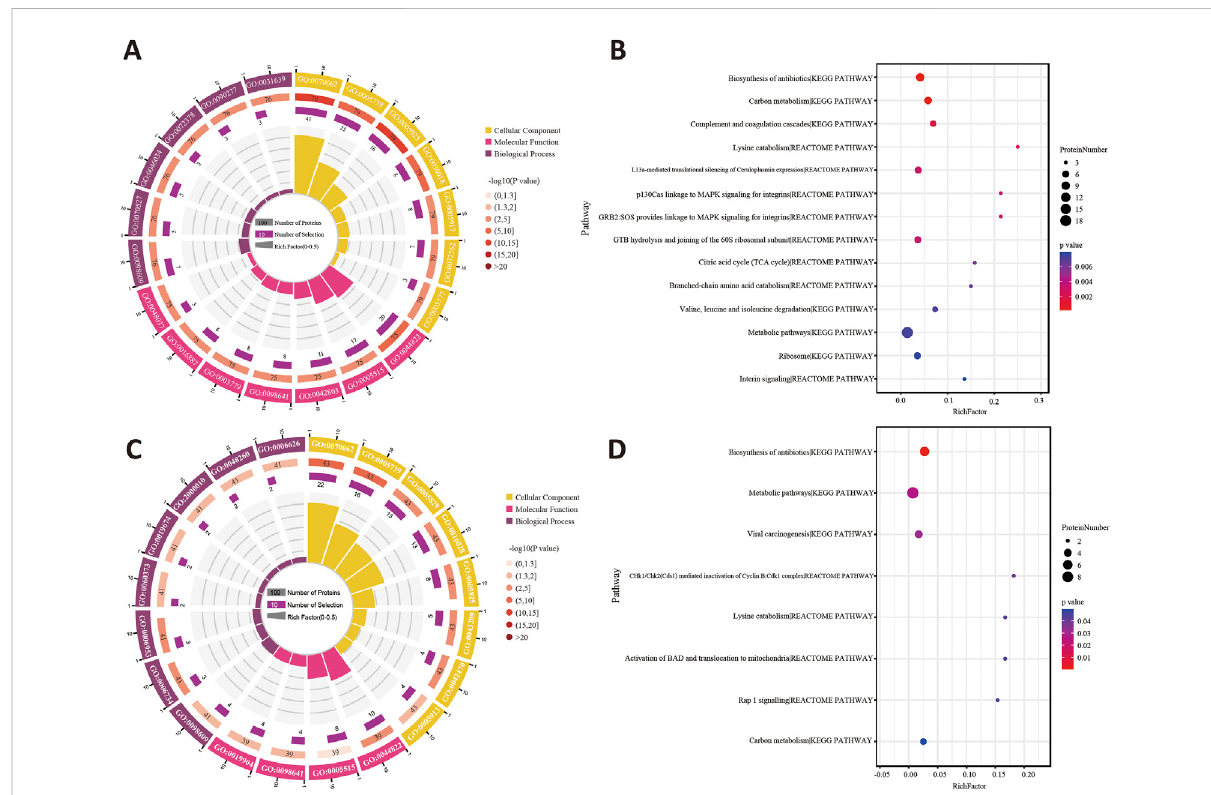
FIGURE 6 (A) Enriched GO terms for the DEPs of Sham: Model using the biological process, cellular component, and molecular function. (B) Statistics of pathway enrichment for the DEPs between the sham group and model group. (C) GO annotation analysis of Model: XST. (D) Classi fi cation of the enriched KEGG pathways and Reactome pathways for the DEPs between the model and XST